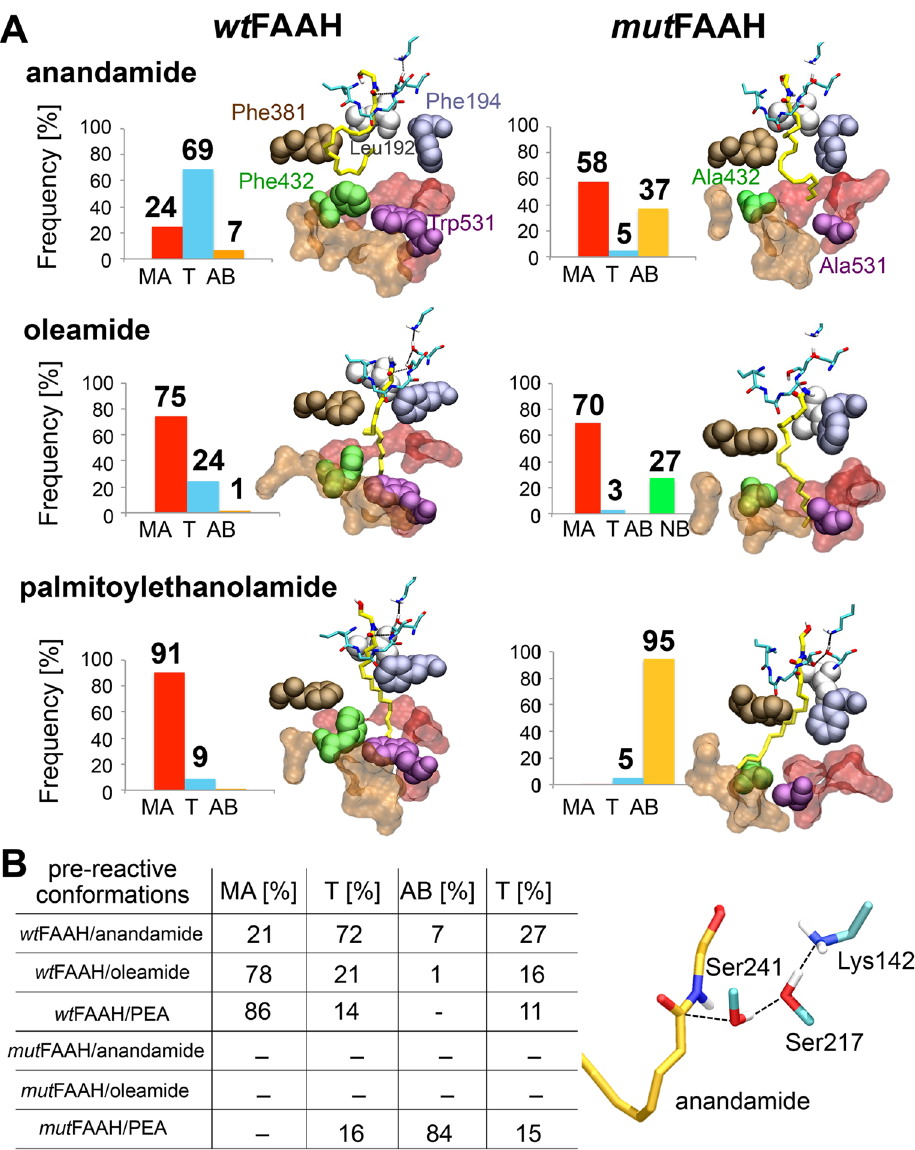
Fig 3. (A) Statistical distribution (% over the total equilibrated conformations — reported as bar graphs) of anandamide (first row), oleamide (second row), and palmitoylethanolamide (PEA — third row) conformations when located in the MA (red bars), T (cyan bars), and AB (orange bars) regions of the wt FAAH (first column) and mut FAAH (second column) systems. For the mut FAAH/oleamide system, the percentage of unbounded oleamide conformations (NB — not-bound) is also indicated with a green bar. For each system, one representative conformation of the most populated state is shown. The MA (red) and AB (orange) channels are shown in molecular surfaces. Key residues of the FAAH active site are in space-filling representation, namely: Leu192 (gray), Phe194 (ice blue), Phe381 (maroon), Phe432 (green), and Trp531 (violet). Phe432 and Trp531 are mutated in Ala in the mut FAAH systems. The substrates (yellow), as well as the catalytic triad and the oxyanion hole (cyan) are also shown in sticks. (B) Percentages of pre-reactive conformations of anandamide, oleamide, and palmitoylethanolamide (in rows) in the MA, T, and AB regions (in columns) of the wt FAAH and mut FAAH systems. The total percentage of pre-reactive conformations over the production runs is also reported in the last column. A representative picture of pre-reactive conformation is also reported (full details are reported in the S1 Text and in S7 Fig).